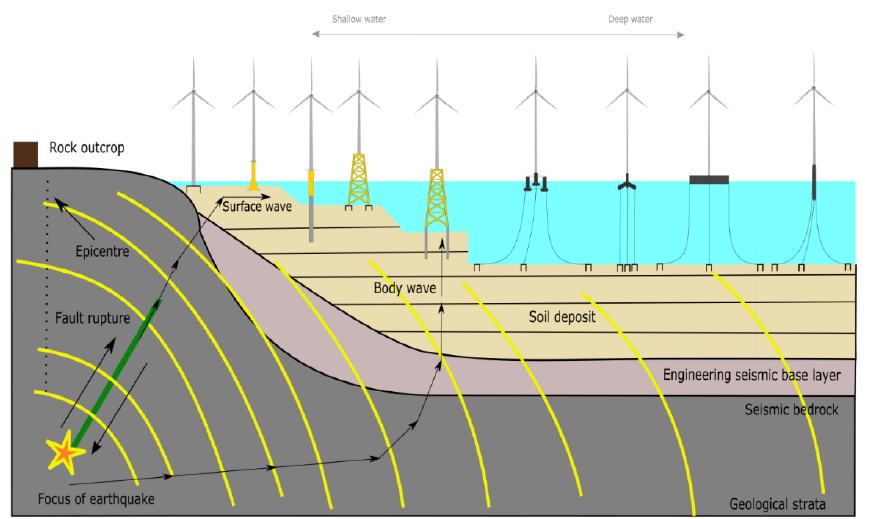
Figure 3. Schematic of hazards due to the arrival of seismic waves for offshore wind turbine structures [5].